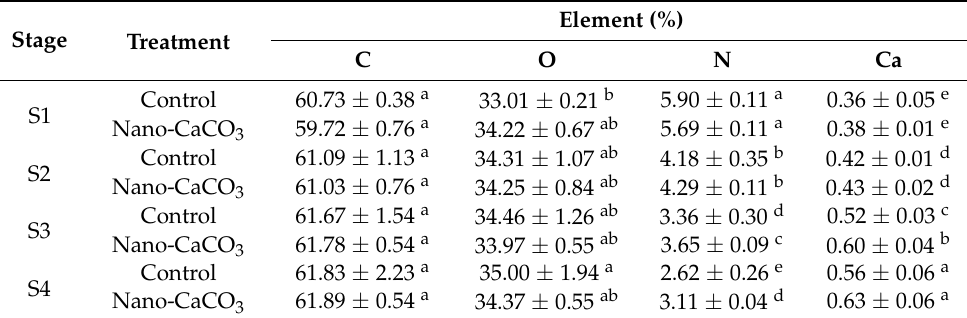
Table 1. Elemental composition of cell walls in P. lactiflora inflorescence stems using X-ray photoelectron spectroscopy (XPS).